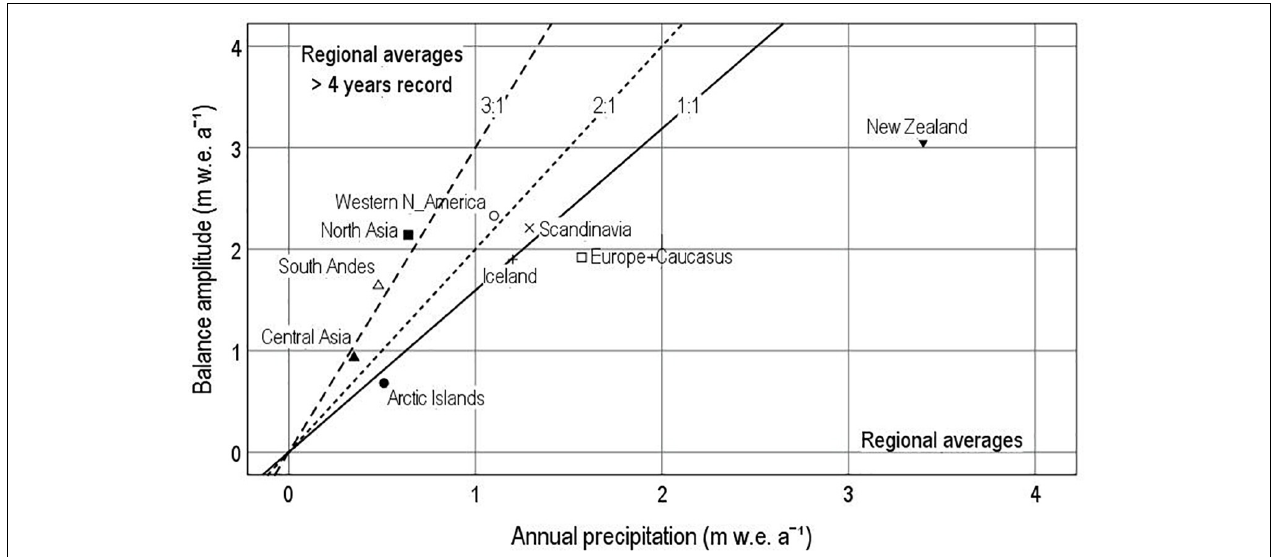
FIGURE 7 | Regional averages for balance amplitude and annual precipitation in nine regions. Balance amplitude data are for glaciers with > 4 years record, and annual precipitation is from Climatic Research Unit (CRU)/University of East Anglia (UEA) gridded climatology (New et al., 1999).